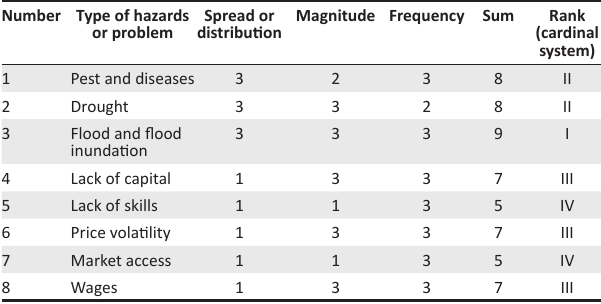
TABLE 2: Hazard and problem